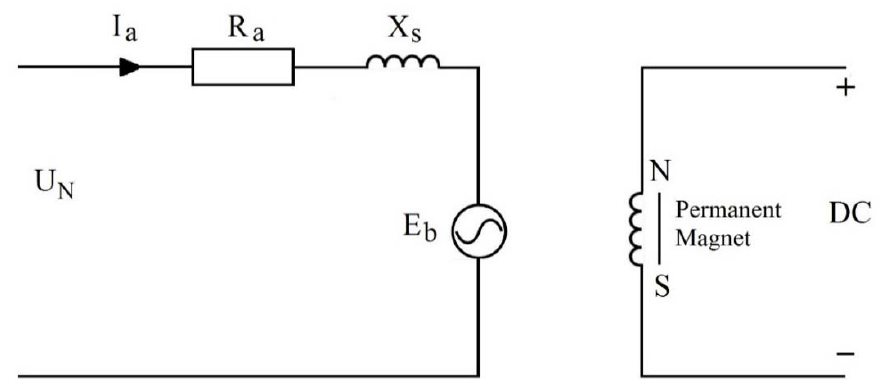
Figure 1. The equivalent circuit diagram of the permanent magnet synchronous motors (PMSM).